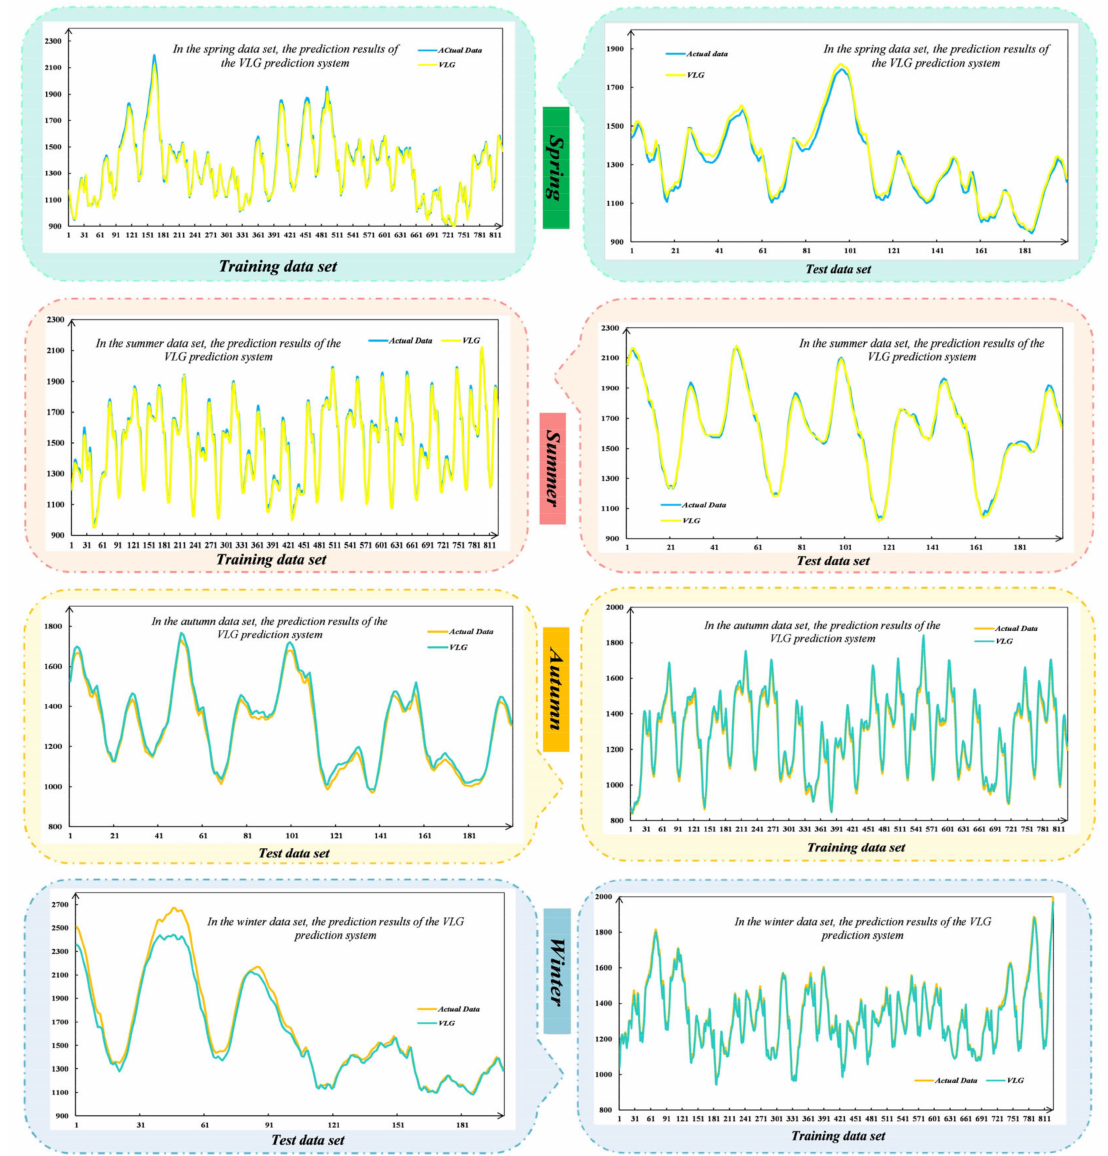
Figure 5. The fit of the VLG prediction system under the training set and test set based on the four seasonal data sets of South